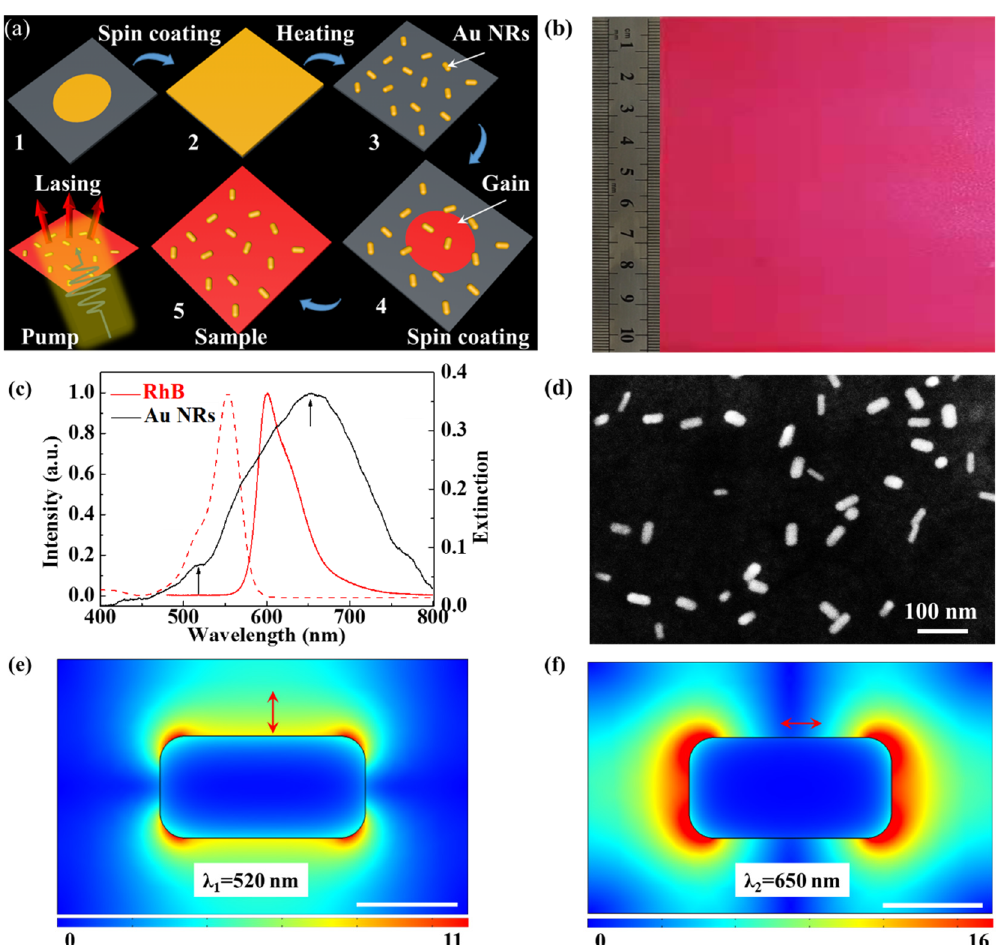
Figure 1. Schematic and imaging of the sample. ( a ) The design and fabrication process of a large-area biocompatible random laser for wearable sensors and their surface with Au NR S is illustrated. ( b ) The optical image is the large-area biocompatible polymer film, the area of which was over 100 cm 2 . ( c ) Normalized absorbance (red dashed line), photoluminescence (red solid line) spectra of RhB, and the extinction (black solid line) of Au NRs. The arrows indicate the plasmonic resonant peak of the Au NRs. ( d ) The scanning electron microscopy image of the Au NRs (scale bar = 100 nm). ( e ) Numerically simulated electric field distribution of TSPR mode at 520 nm. ( f ) Numerically simulated electric field distribution of LSPR mode at 650 nm. Scale bar = 50 nm.